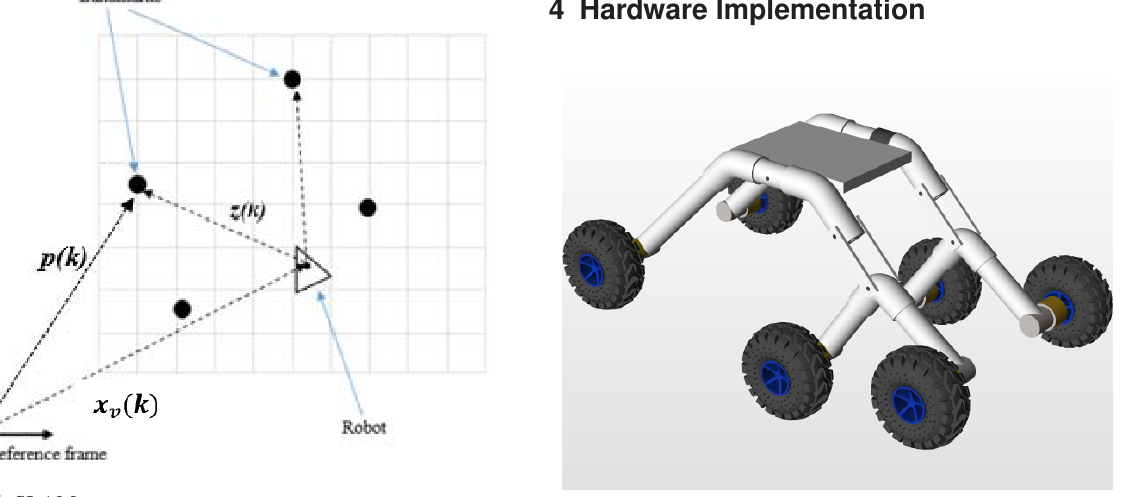
Figure 7. Rocker-Bogie